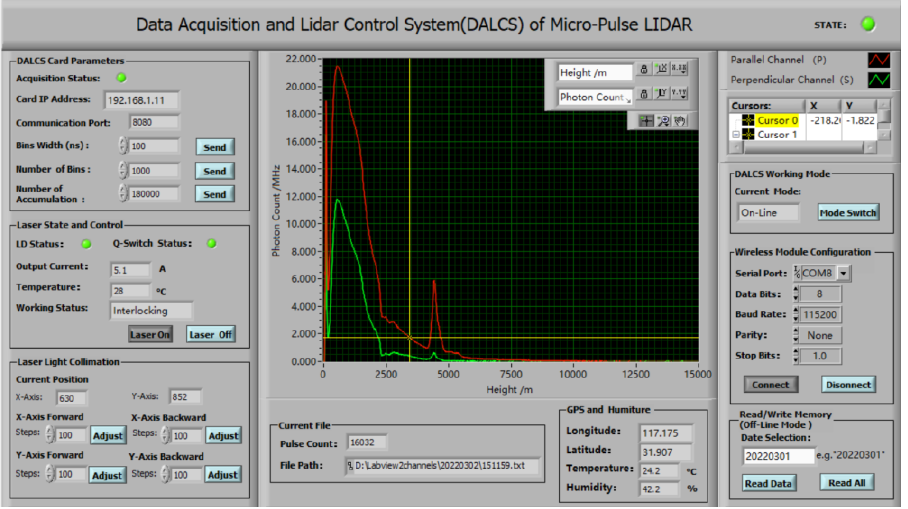
Figure 11. The upper computer software of DALCS.